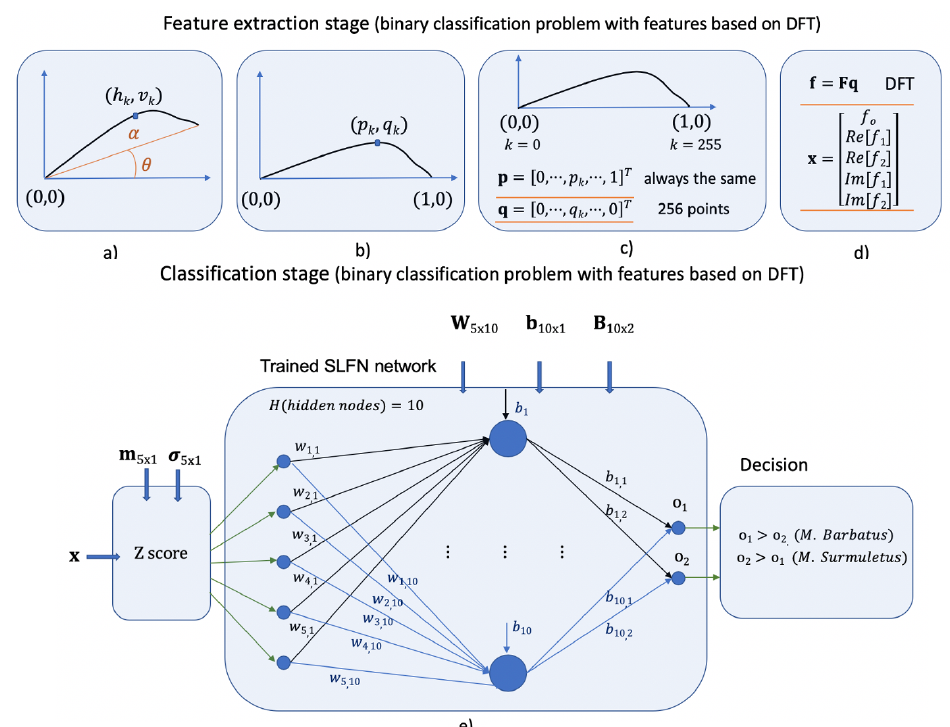
Figure 14. Detail at the parameter level of the feature extraction and classification stages of the binary classification solution working with features based on DFT. ( a – c ) show the steps required to obtain the vector q from the contour, and ( d ) shows the way to obtain the vector x from q . In ( e ), the classification stage is shown with the parameters that interact in each step. The matrices and vectors show their dimensions in a subscript (in order to check the coherence of the operations involved). In the classification stage, three parts, the Z-score normalization, an LSFN network of 10 hidden nodes, and the decision rule, are employed.